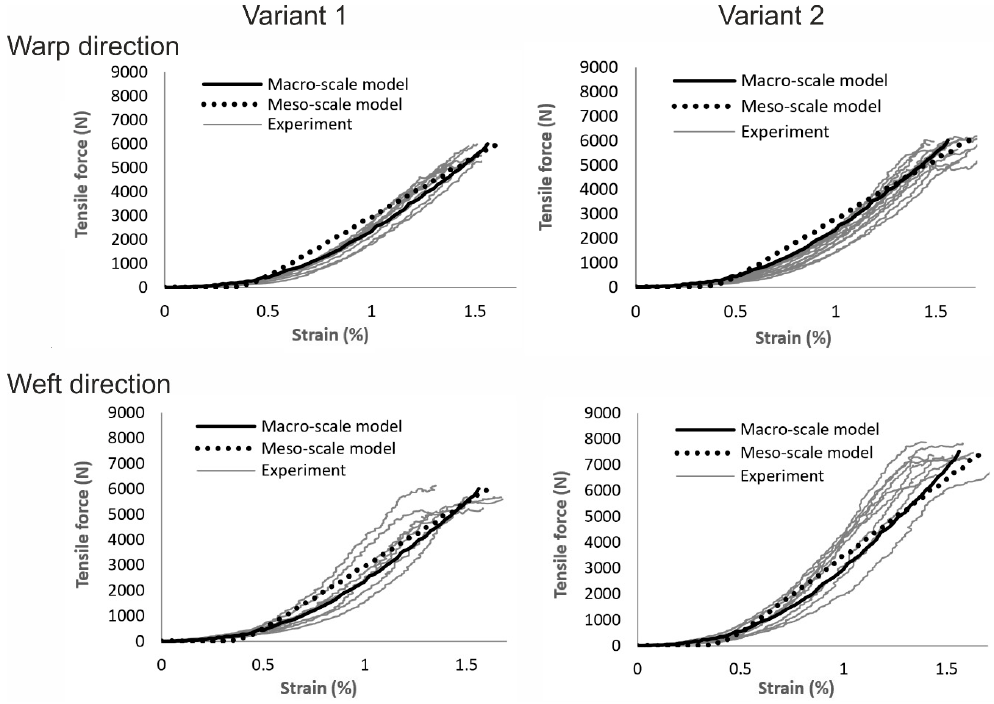
Figure 10. Comparison of tensile force-strain curves between experiments and simulations (16 samples of variant 1 in warp direction, 9 samples of variant 1 in weft direction, 14 samples of variant 2 in warp direction, and 10 samples of variant 2 in weft direction).